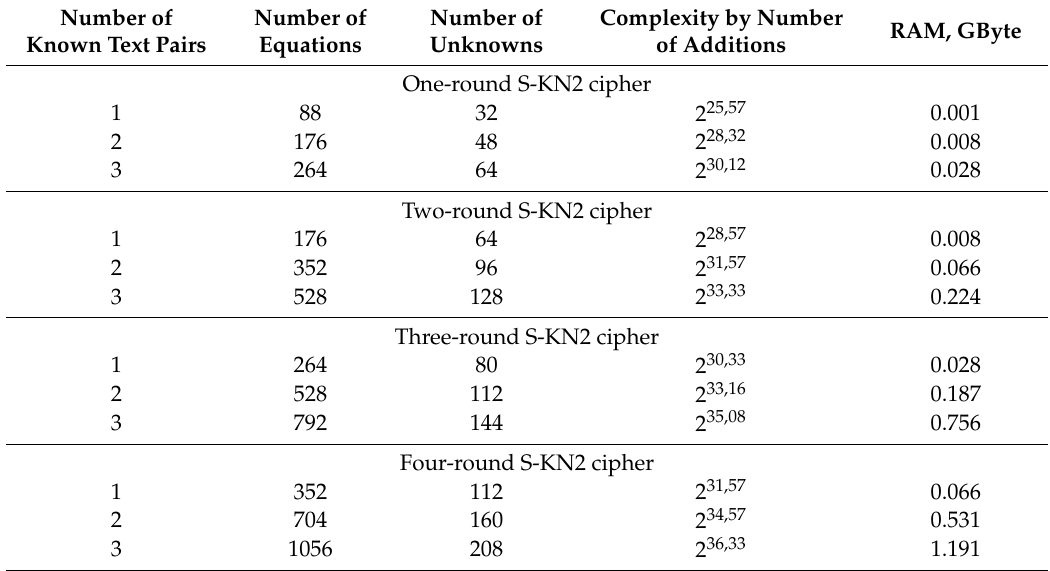
Table 6. Evaluated complexity of the algebraic analysis of the S-KN2 cipher by the XL